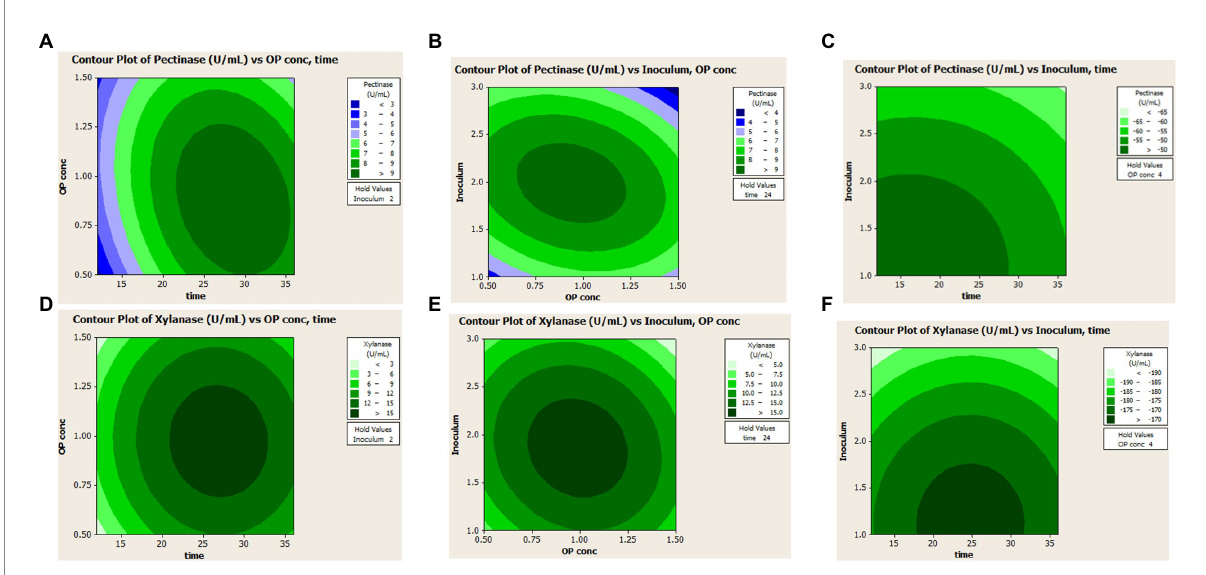
FIGURE 5 Contour plot showing the interaction effects of orange peel concentration (OP conc), Incubation period (hour), and inoculum volume (Inoculum) on pectinase (A–C) and xylanase (D–F) activities.